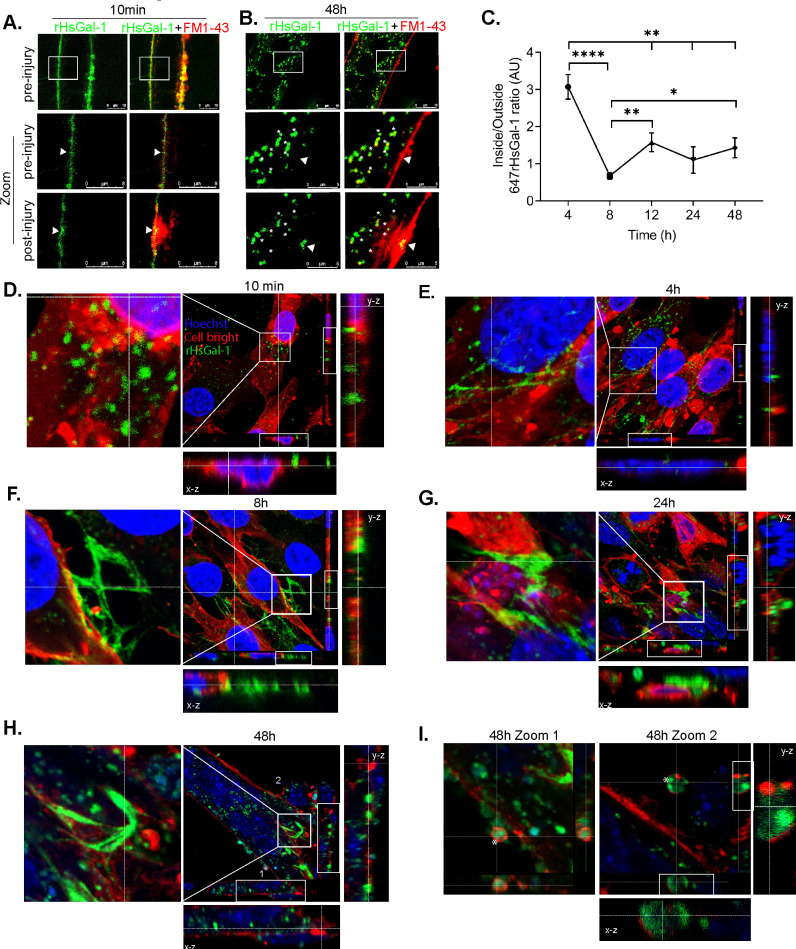
rHsGal-1 localizes at the site of injury and is found in intra and extracellular spaces.A–B. Representative images of laser ablation assay with labeled 647rHsGal-1 (green) and FM1-43 Dye (red) with treatment time of 10min(A) and 48h(B). White arrows indicate site of injury. C. Quantification of the average ratio of corrected total cell 647rHsGal-1 fluorescence between inside and outside of the cell. D-I. Confocal images of A/J -/- myoblasts/myotubes treated and differentiated with 0.11 μM rHsGal-1 at varying time points: 10min (D), 4 h (E), 8 h (F), 24 h (G), 48 h (H), with labeled rHsGal-1(647rHsGal-1) (green) showing nucleus (blue) and membrane (red) identifying critical structures pertaining to rHsGal-1 location. 1 and 2 represents vesicle localization (I). Zoom: rHsGal-1 encapsulated in vesicles.